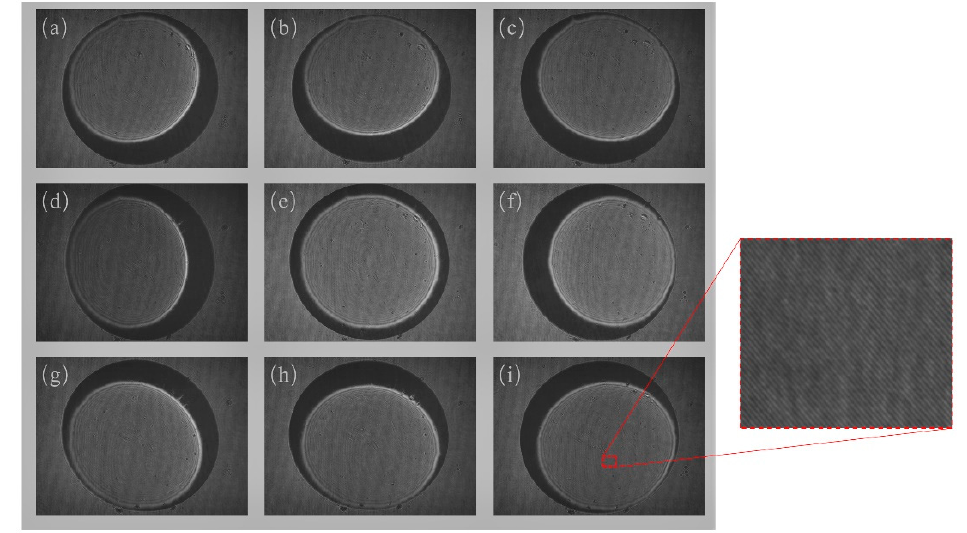
Figure 8. Holograms of microlens with nine different rotation angles. ( a ) θ = 10 ◦ , β = 10 ◦ . ( b ) θ = 0 ◦ , β = 20 ◦ , ( c ) θ = − 10 ◦ , β = 10 ◦ , ( d ) θ = 20 ◦ , β = 0 ◦ , ( e ) θ = 0 ◦ , β = 0 ◦ , ( f ) θ = − 20 ◦ , β = 0 ◦ , ( g ) θ = 10 ◦ , β = − 10 ◦ , ( h ) θ = 0 ◦ , β = − 20 ◦ , ( i ) θ = − 10 ◦ , β = − 10 ◦ .